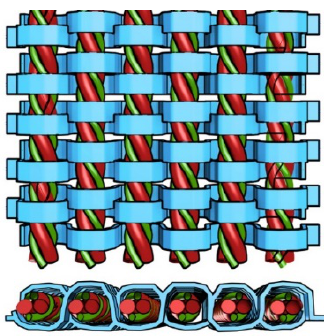
Figure 4. Woven fabric design with crimp-free auxetic plied yarns.